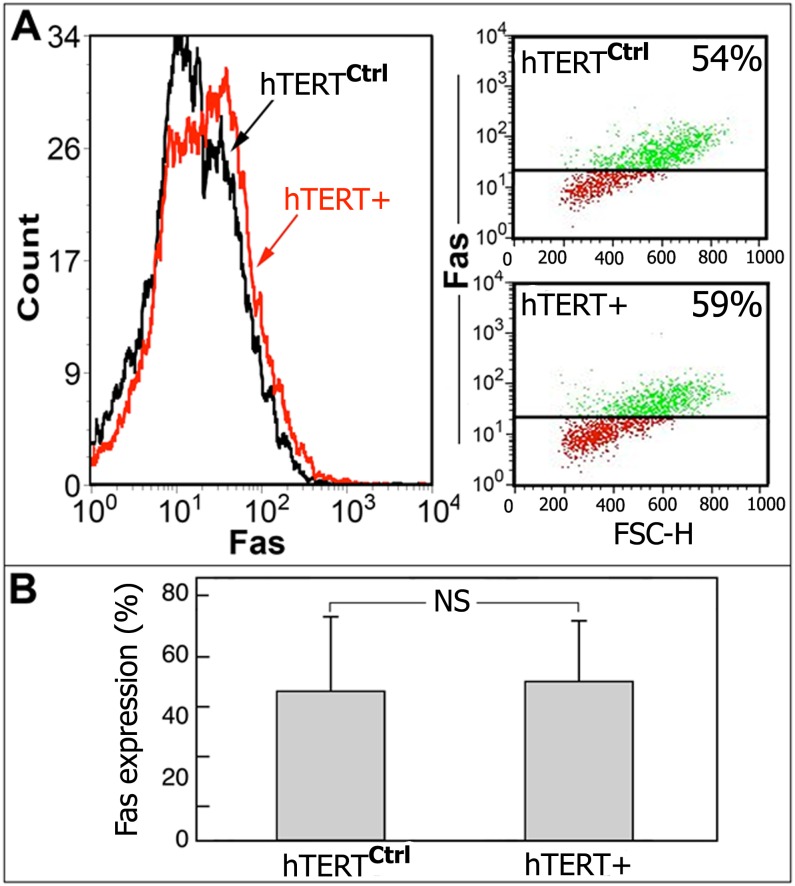
Fas expression is unchanged in hTERT+-transfected MLE cells.(A) Flow cytometry analysis (histogram and dot plots) showing similar Fas expression in hTERT+ vs. hTERTctrl MLE cells. (B) Graphic presentation of FACS analysis from three independent experiments (n = 4).